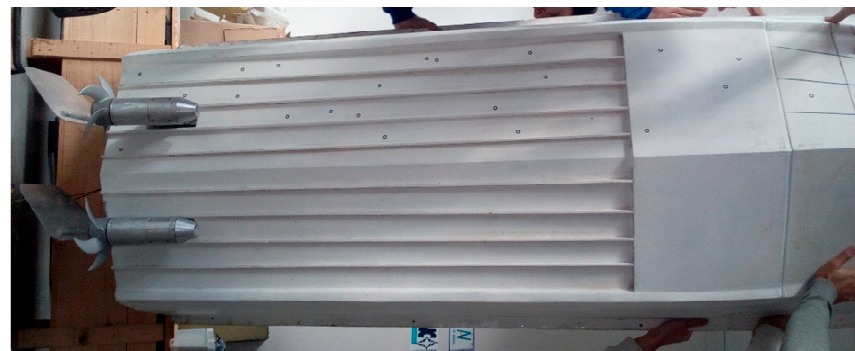
Figure 2. The bottom of the hull.